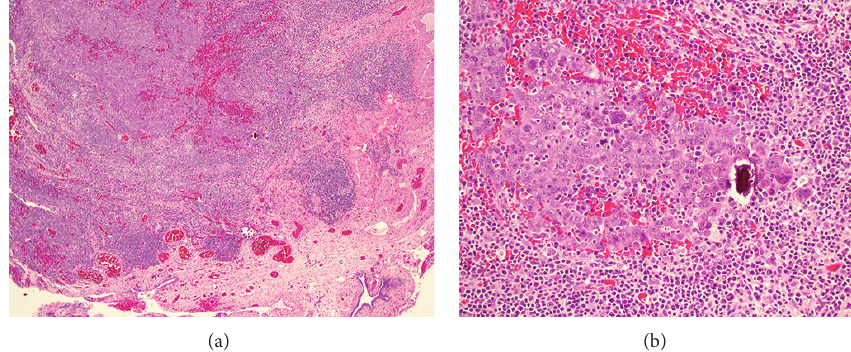
Figure 2: (a) H&E stained section, including the fimbriated end of the fallopian tube from the total abdominal hysterectomy and salpingo- oophorectomy specimen, demonstrates an invasive lesion. (b) H&E stained section, at a higher magnification, shows high grade serous carcinoma with psammomatous calcification, sharing the morphology of the axillary metastasis (Figure 1) and inguinal metastasis (not